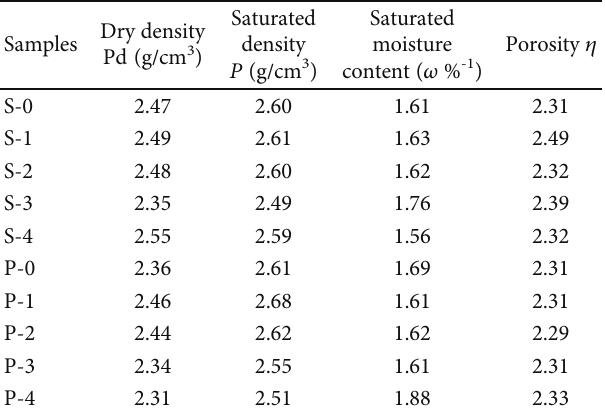
Table 1: Primary index of two samples. Dry density Samples Pd (g/cm 3